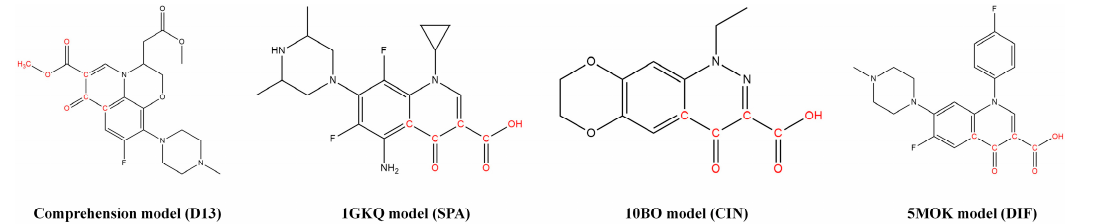
Figure 1. Schematic diagram of template molecules and their common skeleton in FQ biodegradabil- ity